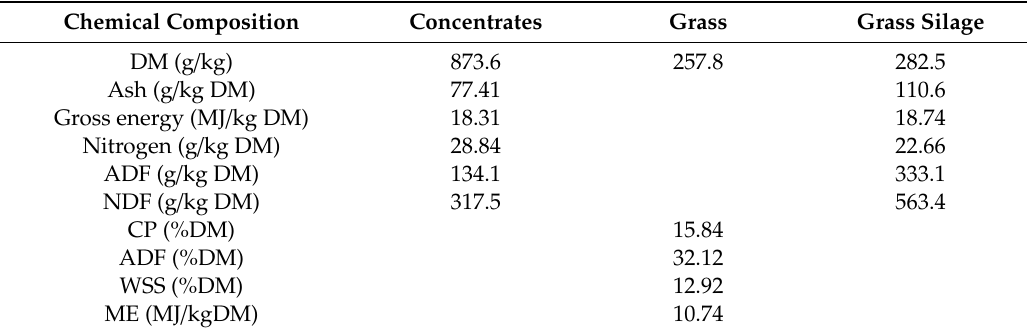
Table 2. Mean chemical composition of feed o ff ered to